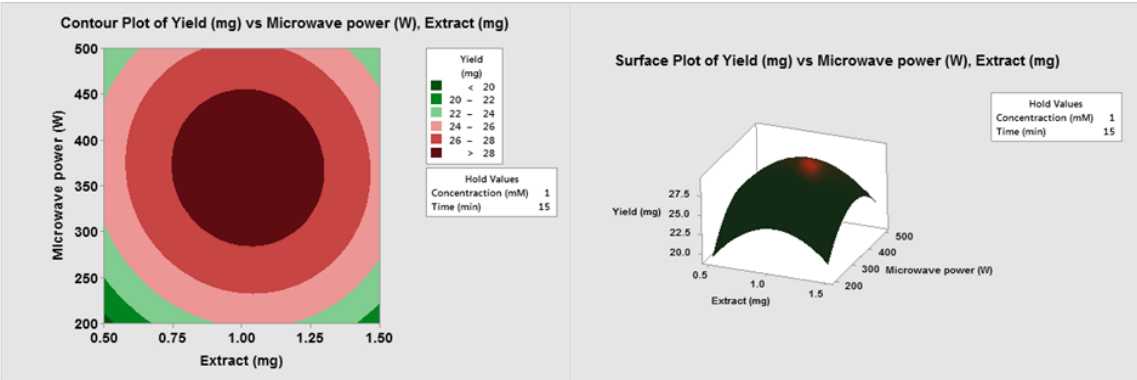
Figure 2. Fungal biomass (extract) and microwave power effect on NP yield.